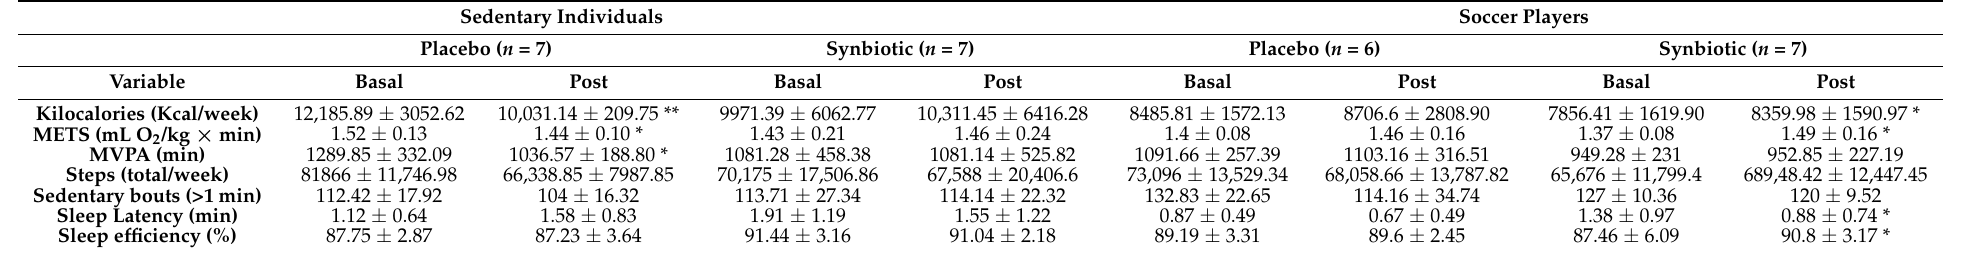
Table 2. Physical activity levels, sedentary lifestyle, and sleep quality determined by accelerometry.